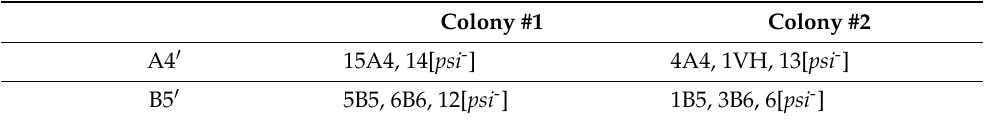
Table 3. Reverse cytoduction (Hsp104 T160M → WT ).